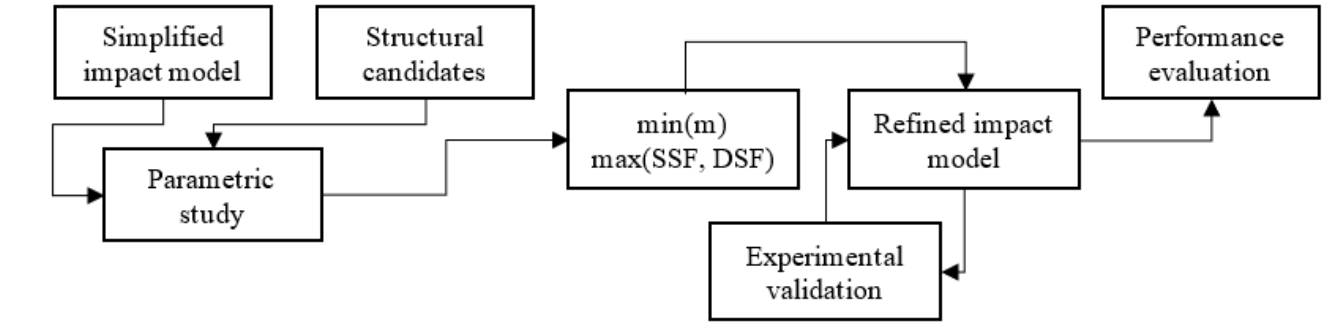
Figure 2. Investigative methodology for studying ice impact.